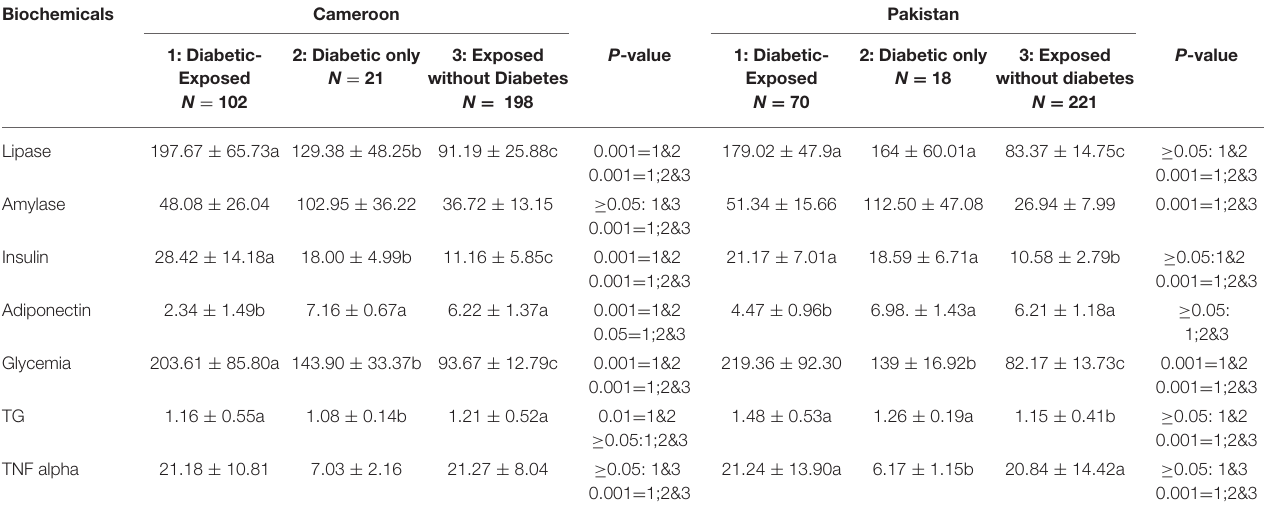
TABLE 5 | Variation of Biochemical tests according to Type 2 diabetes.